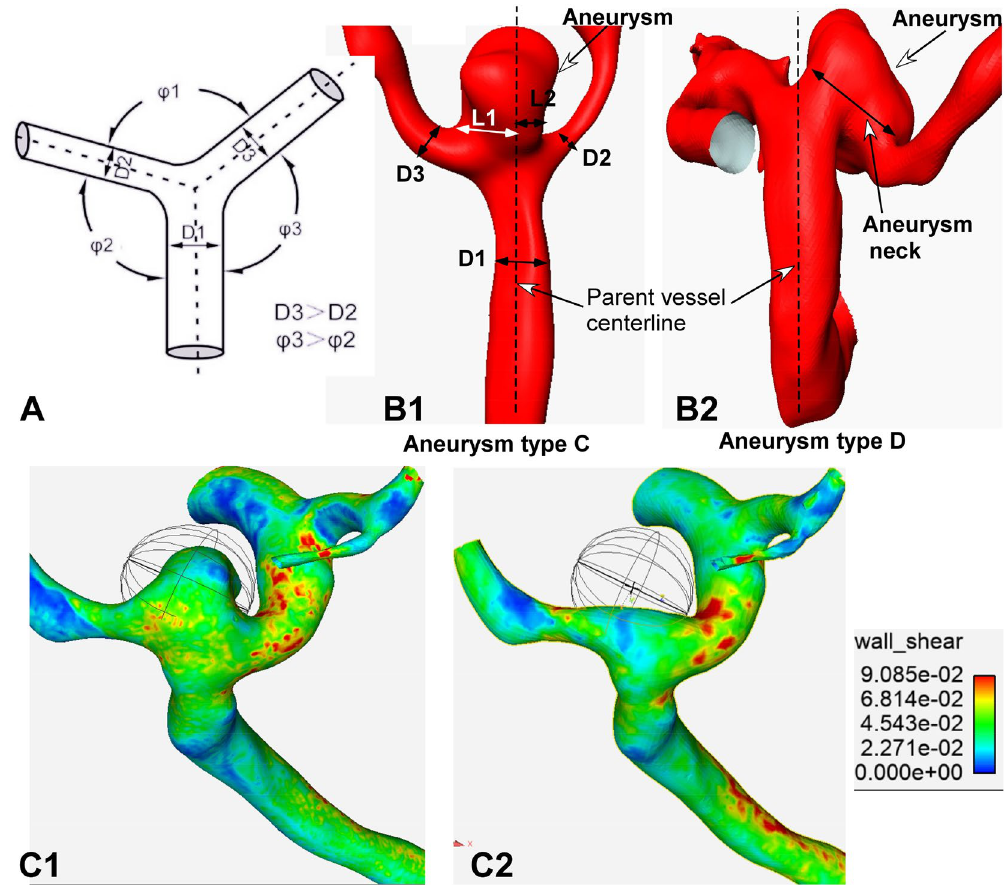
Figure 1. Measurement of arterial morphology. ( A ) Schematic drawing shows the definition of D1–D3, and φ1–φ3. The diameter of the parent artery is D1, and the bifurcation angle between branching arteries is φ1. The larger lateral angle and larger daughter branch are defined as angle φ3 and D3, respectively, whereas the samller contralateral lateral angle and branch artery are termed as φ2 and D2, respectively, with D3 > D2 and φ3 > φ2. ( B1 – B2 ) Types of aneurysms based on the aneurysm neck. ( B1 ) Classical aneurysms (type C aneurysms) are those in which the parent vessel centerline passes through the aneurysm neck. The aneurysm neck is divided into 2 sections: L1 and L2. If L1 is greater than L2, the aneurysm deviates towards the L1 side. Otherwise, it dviates towards the other side. ( B2 ) Type D aneurysms are those with a deviating neck in which the parent vessel centerline does not pass through the aneurysm neck. ( C1 , C2 ) Sphere sampling is shown. ( C1 ) A sphere is used to sample the hemodynamic stresses on the aneurysm dome. ( C2 ) A sphere is used to sample the hemodynamic stresses on the aneurysm initiation site after virtual aneurysm